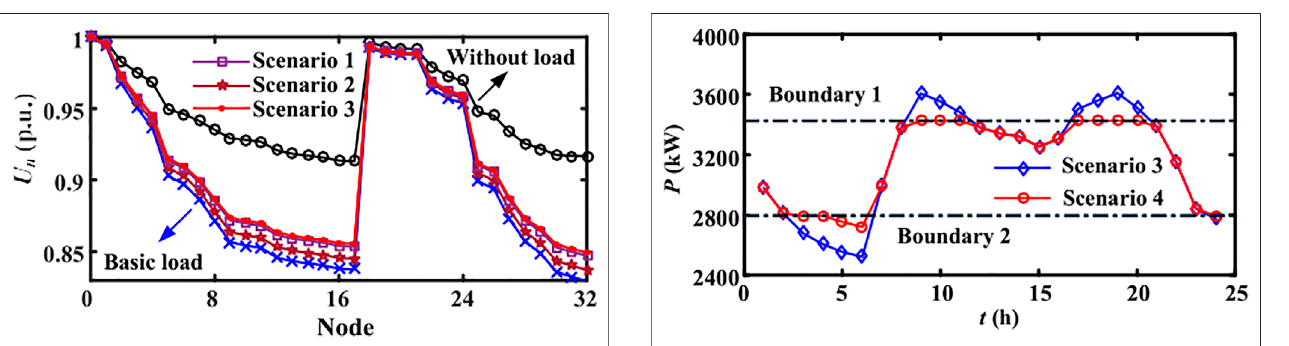
FIGURE 17 | Load curves under different scenarios of EVs.